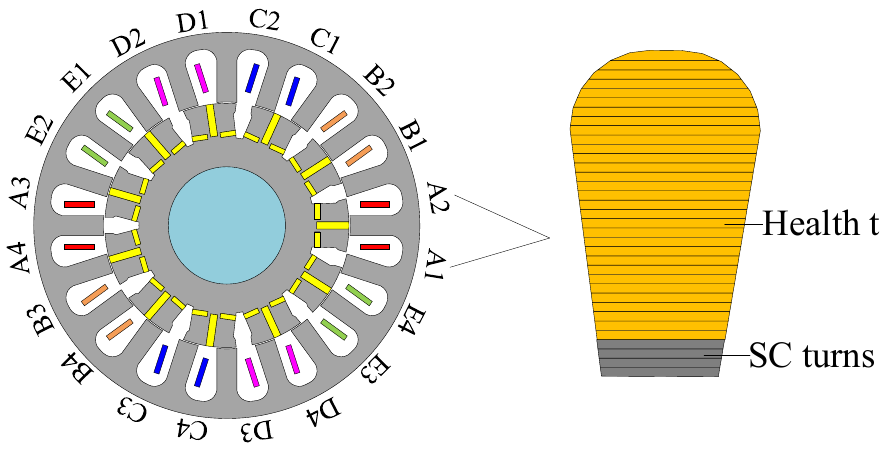
Figure 5. Model of SC turns in phase A.